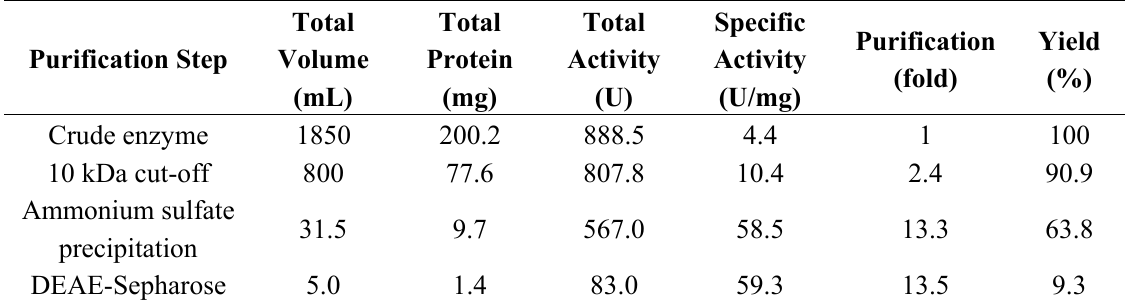
Table 1. Purification summary of NS2B-NS3 pro in P. pastoris